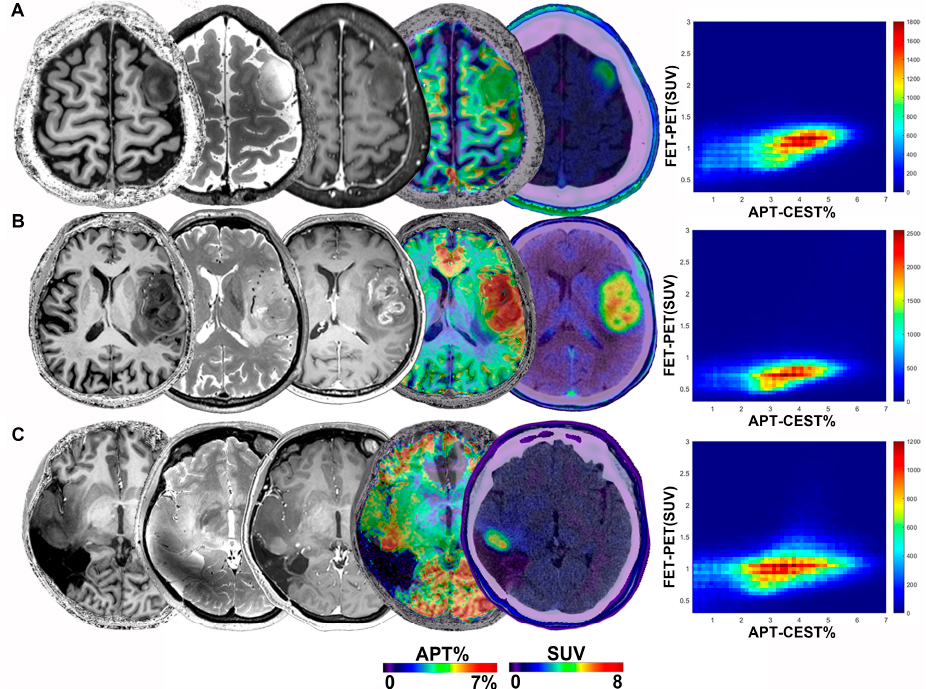
Figure 1. T1-weighted, T2-weighted, contrast-enhanced T1-weighted, APT-weighted MR images, FET-PET images of a 34-year-old male patient with an IDH mutant astrocytoma (WHO Grade II) ( A ), a 70-year-old male patient with an IDH wildtype glioblastoma (WHO Grade IV) ( B ) and a 46-year- old female patient with an IDH mutant recurrent astrocytoma (WHO Grade IV) ( C ). The bivariate histograms between APT values and SUV were present in the right panel,